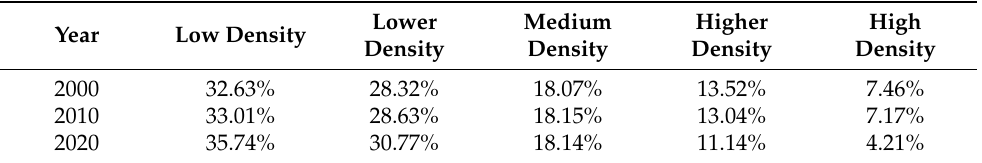
Figure 4. Spatial distribution of cultivated land kernel density in Guangdong Province in 2000 ( a ), 2010 ( b ), and 2020 ( c ). The spatial distribution of cultivated land kernel density in Guangdong Province in 2000, 2010, and 2020 are displayed in ( a ), ( b ), and ( c ), respectively. Table 3. The area ratio of each cultivated land kernel density grade zone in Guangdong Province